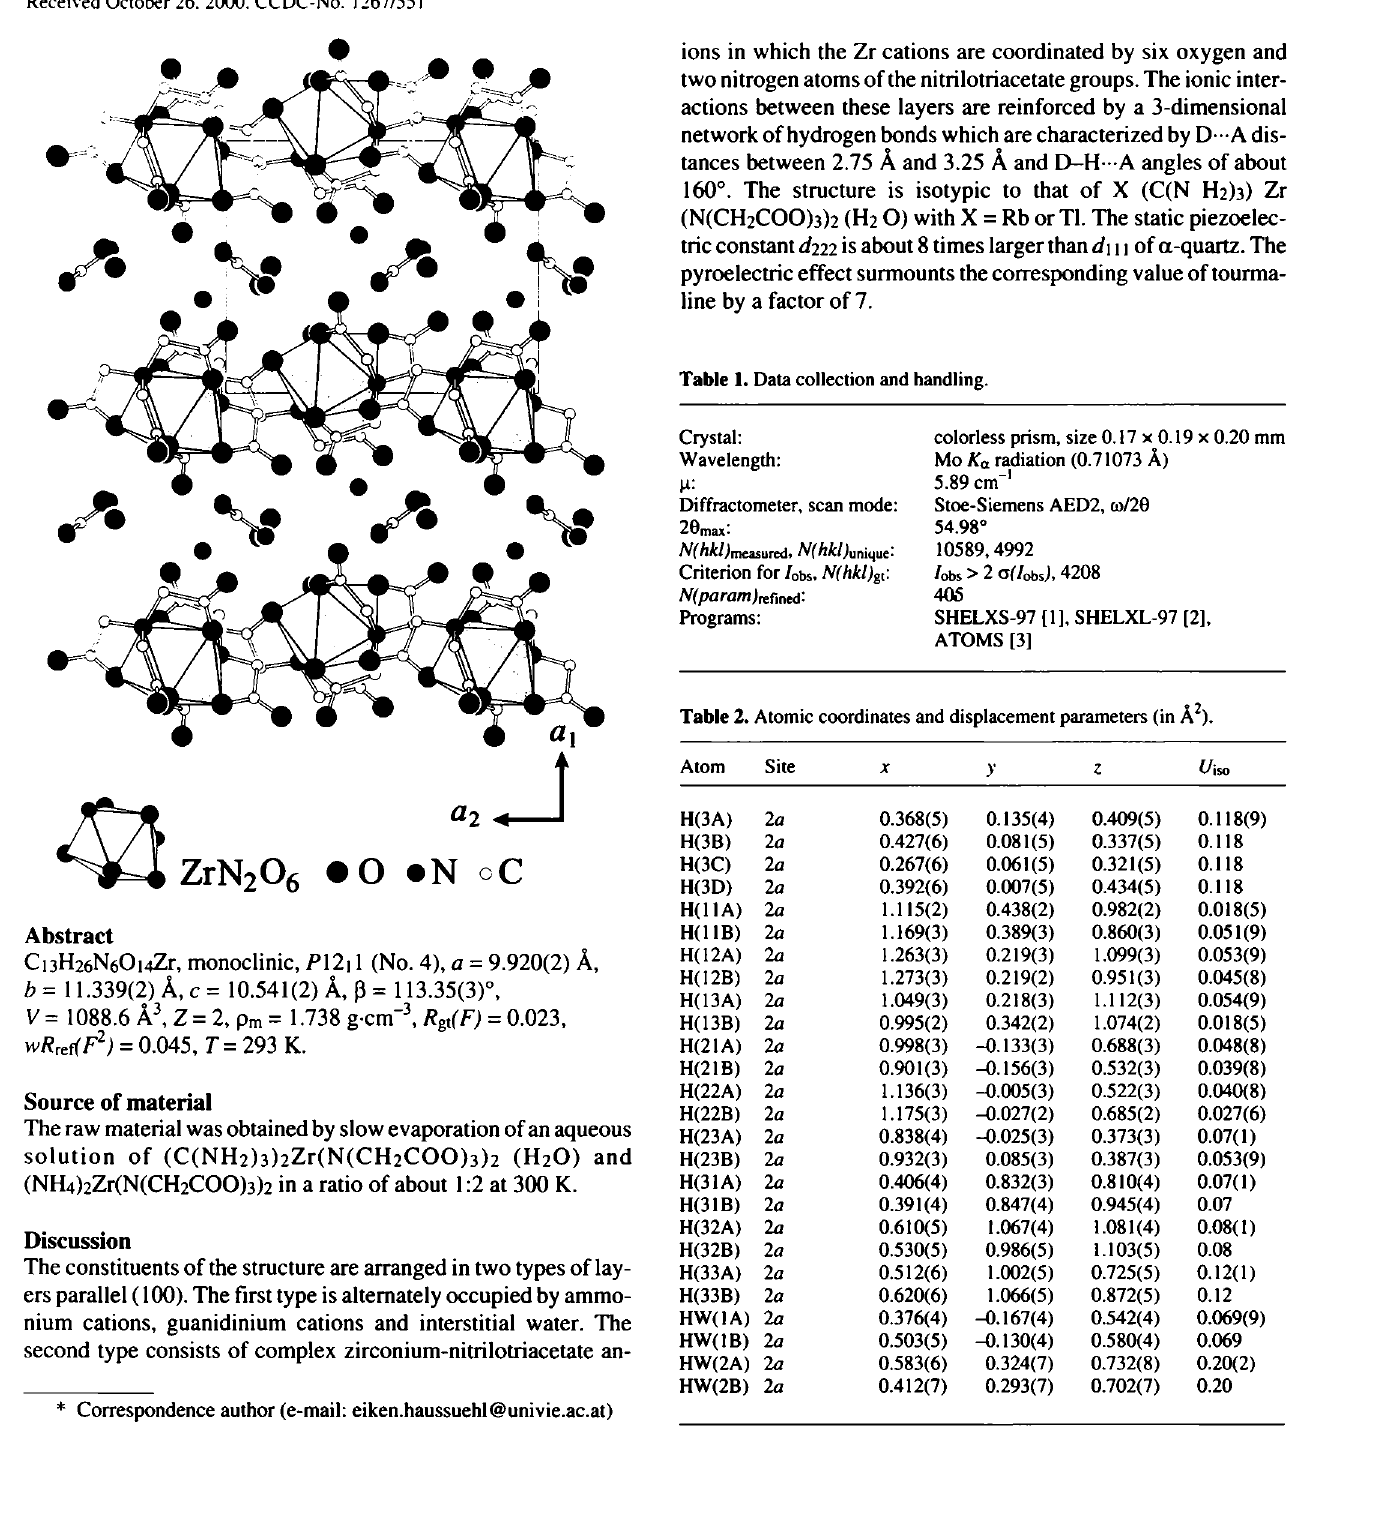
Table 1. Data collection and handling.